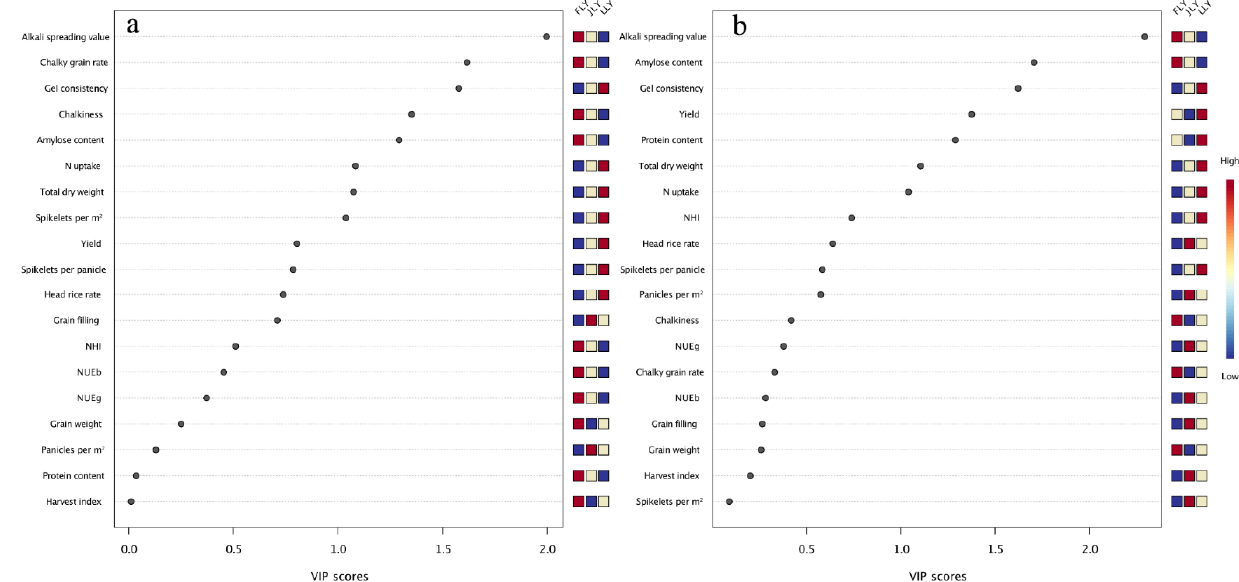
Figure 1. Differences between hybrid varieties derived from 4155S (JLY), hybrid varieties derived from longke638S (LLY) and the control variety Fengliangyou4 (FLY) in parameters related with grain yield, grain quality, and nitrogen use efficiency in 2019 ( a ) and 2020 ( b ). Variable Importance in Projection (VIP) is a weighted sum of squares of the Partial Least Squares (PLS)loadings taking into account the amount of explained Y-variation in each dimension shown in Figure S2. Table 1. The yield of tested hybrid rice varieties in 2019 and 2020.